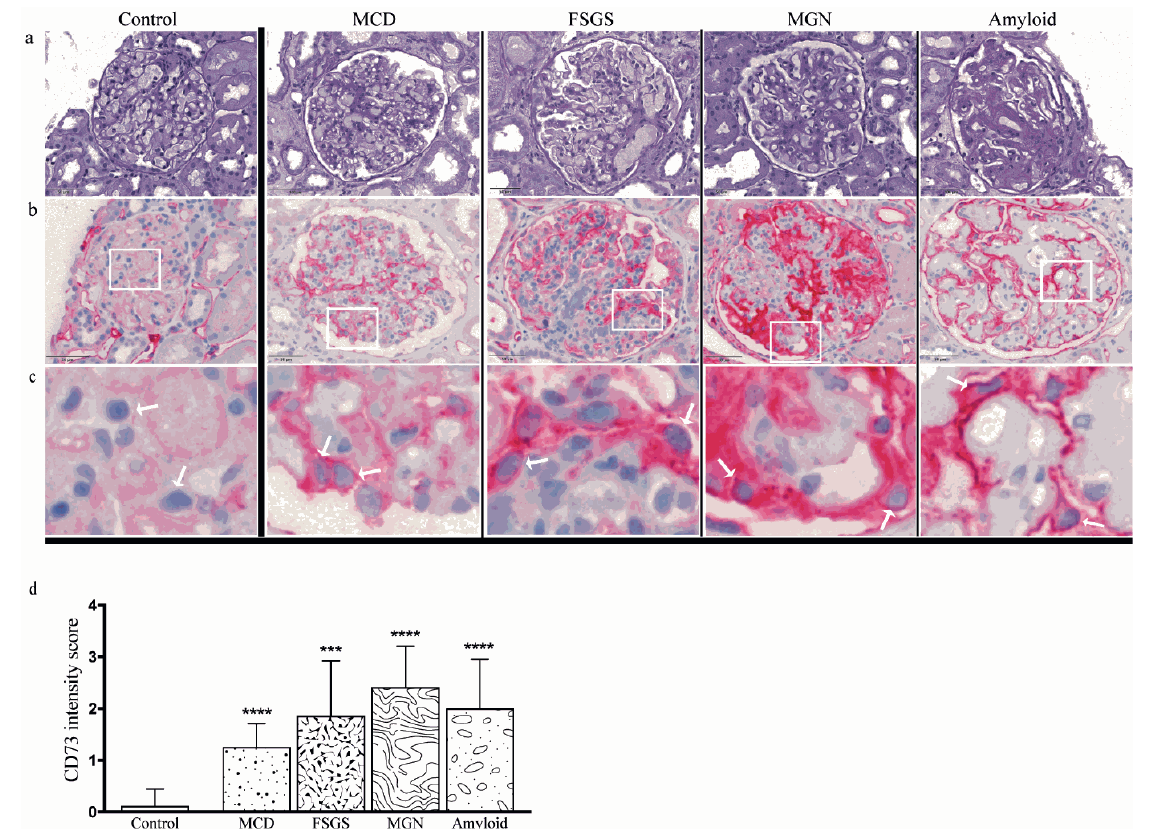
Figure 2. Surface expression of CD73 by injured podocytes. Negative CD73 immunohistochemistry in the control group (left column) in contrast to strong CD73 expression in primary and secondary podocytopathy groups (MCD — minimal change disease, FSGS — focal segmental glomerulosclerosis, MGN — membranous glomerulonephritis; ( a ) light microscopy photomicrographs, 40×/0.65 NA, PAS, ( b ) corresponding CD73 immunohistochemistry, 40×/0.65 NA, ( c ) 3× digital magnification from ( b ) with focus on podocytes (arrows). ( d ) Bar graph showing significant upregulation of podocyte expression in MCD, FSGS, MGN and amyloid groups in comparison to controls. Statistical differences were evaluated by unpaired t -test; ***, p < 0.001 and ****, p < 0.0001.